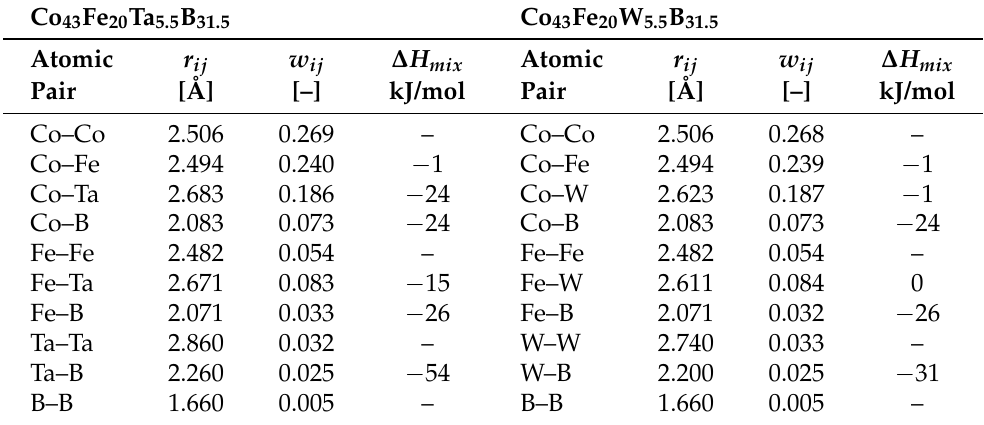
Table 1. Bond lengths r ij , X-ray weighting factors w ij and enthalpy of mixing ∆ H mix [36] of atomic pairs in Ta- and W-containing alloys. Bond lengths r ij of atomic pairs were calculated as a sum of nominal atomic covalent radii. Weighting factors w ij were calculated for q = 0Å − 1 using Equation